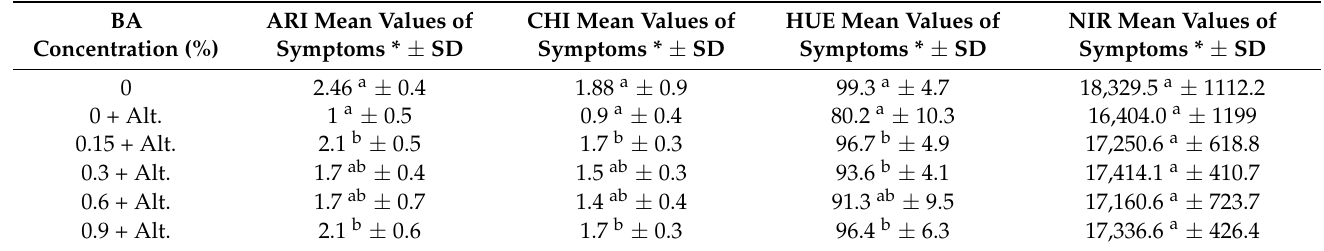
Table 6. Physiological parameters of tomato plants pretreated with BA and inoculated 2 days later with Alternaria alternata , and measured 15th day